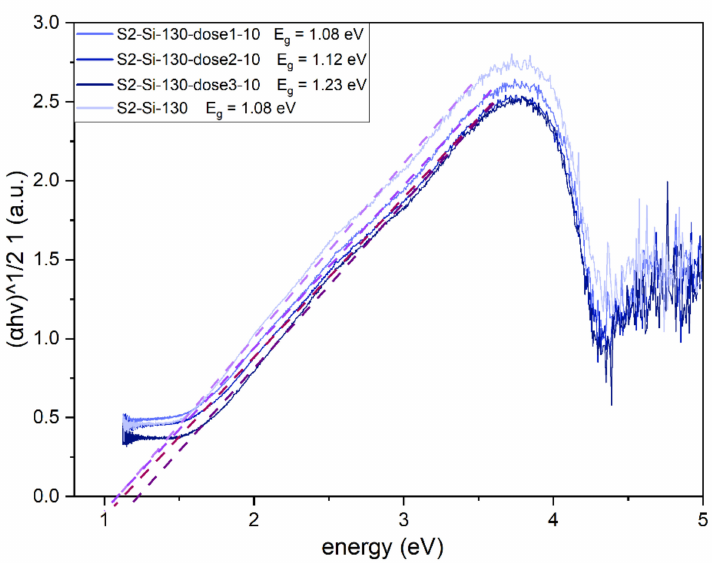
Figure 10. Tauc plot for II series samples with estimated indirect bandgap of CuO. The bandgap value increases with increasing dose of